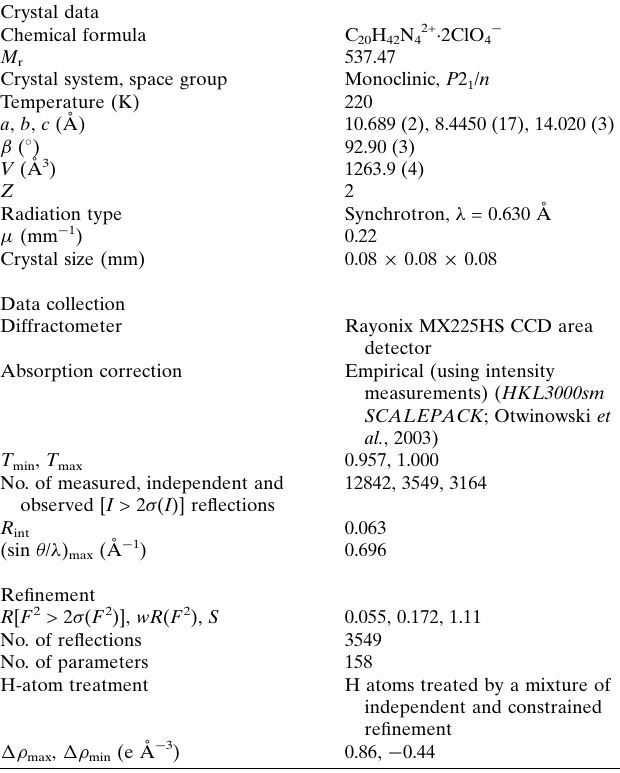
Table 2 Experimental details. Crystal data Chemical